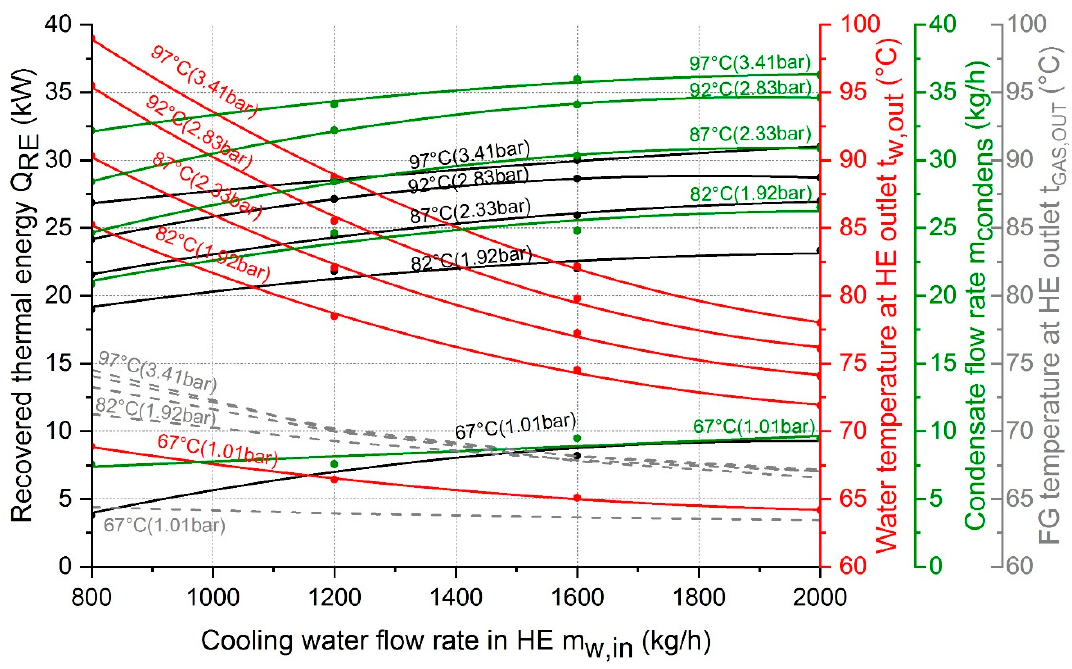
Figure 7. Influence of the cooling water flow rate in the HE and the dew point temperature on the recovered thermal energy (black lines), the water temperature at the HE outlet (red lines), the condensate flow rate (green lines) and the flue gas temperature at the HE outlet (gray lines) for concept 3.